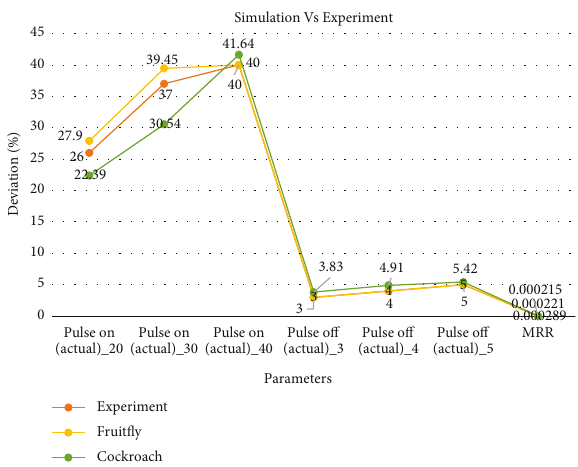
Figure 14: Deviation in MRR and its respective parameter values of mild steel predicted by fruit fly and cockroach algorithm with laboratory experiment values.